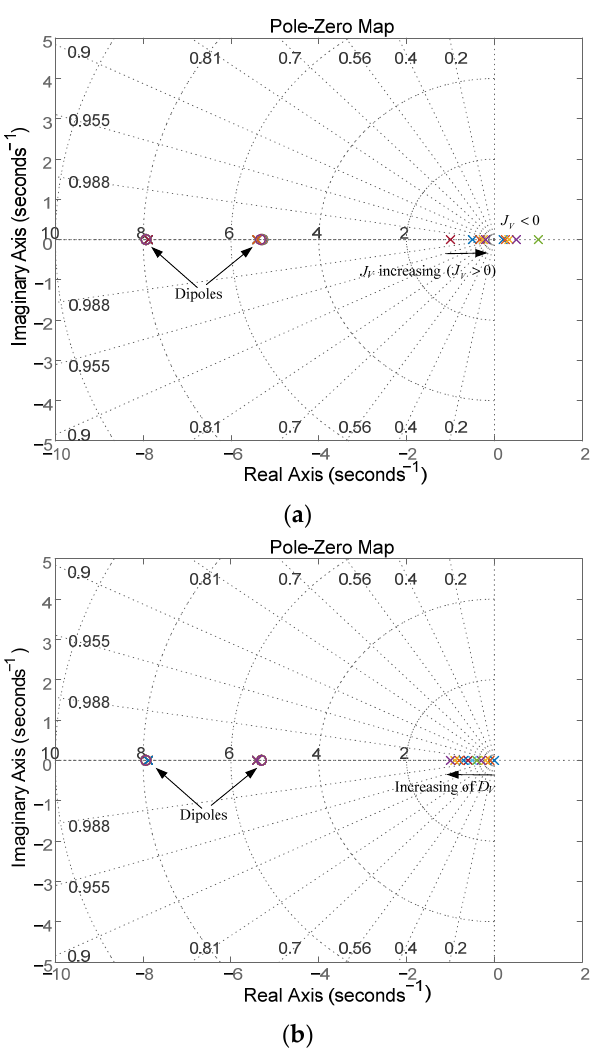
− 1 to 1; ( b ) D V changing from V changing from 0 to